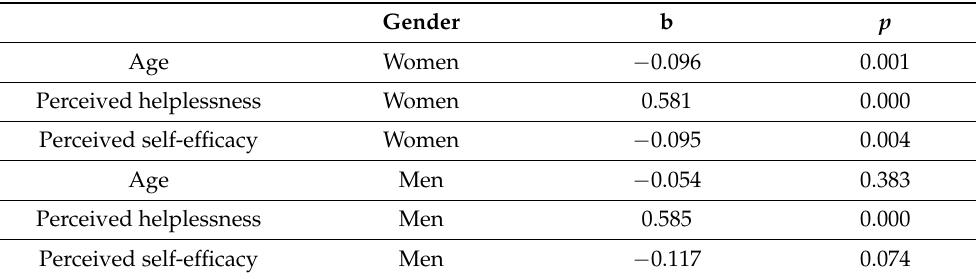
Table 7. Regression results for exhaustion (dependent variable) and perceived helplessness and self-efficacy (independent variables) divided by